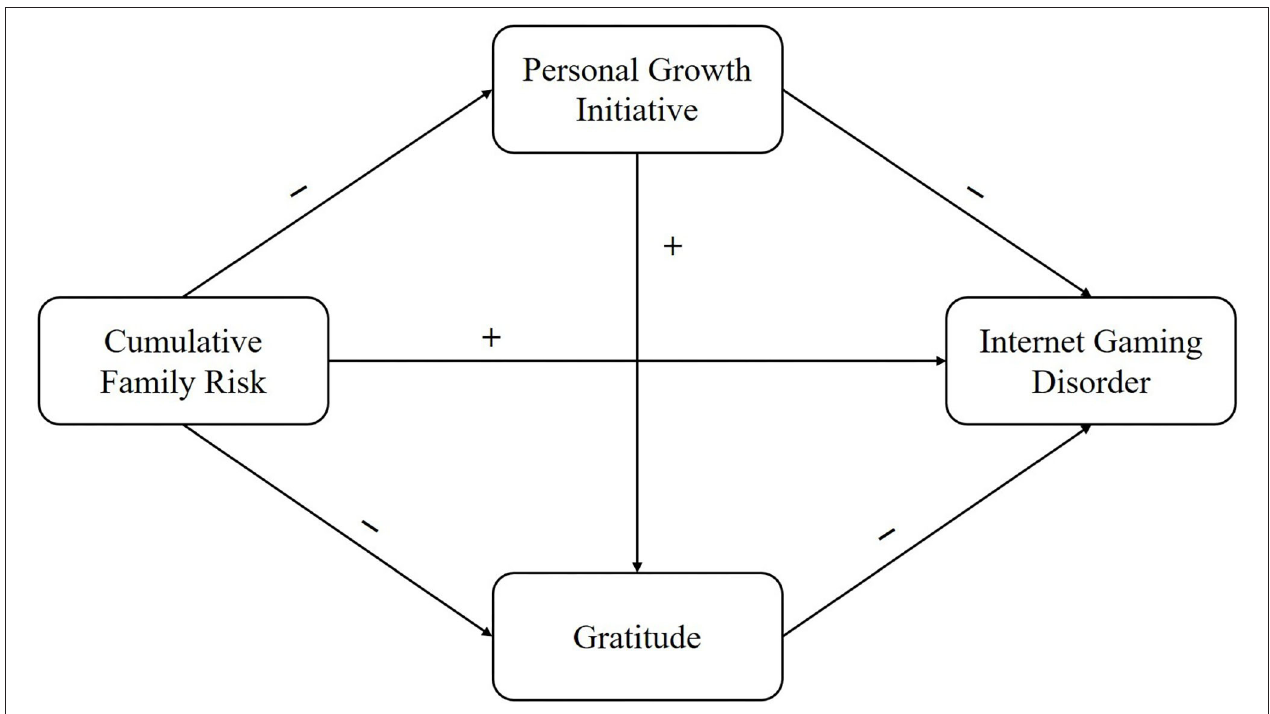
FIGURE 1 | The hypothesized multiple mediation